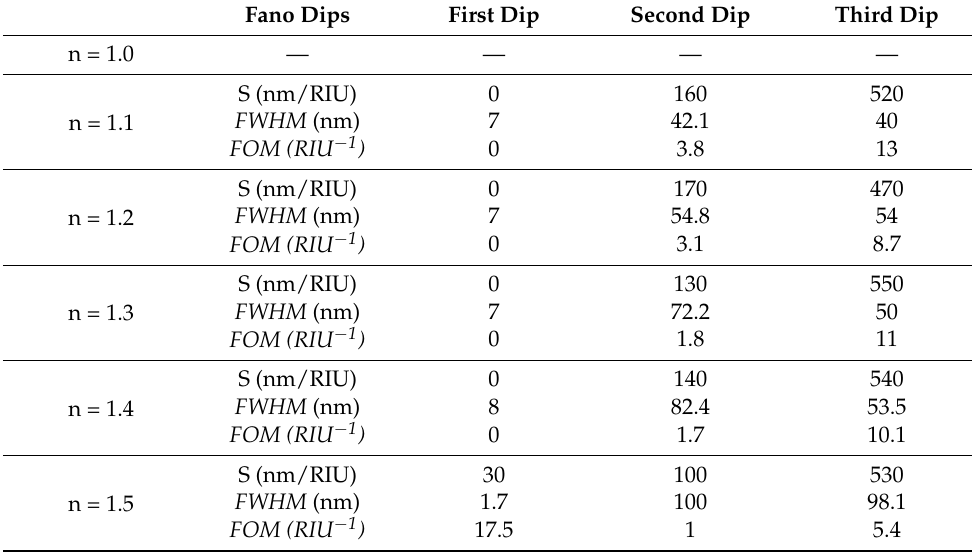
Table 2. FOM of the nanostructure for different refractive indexes. Fano Dips First